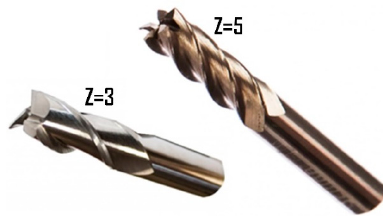
Table 2. Chemical composition of the 41Cr4 steel used for testing.